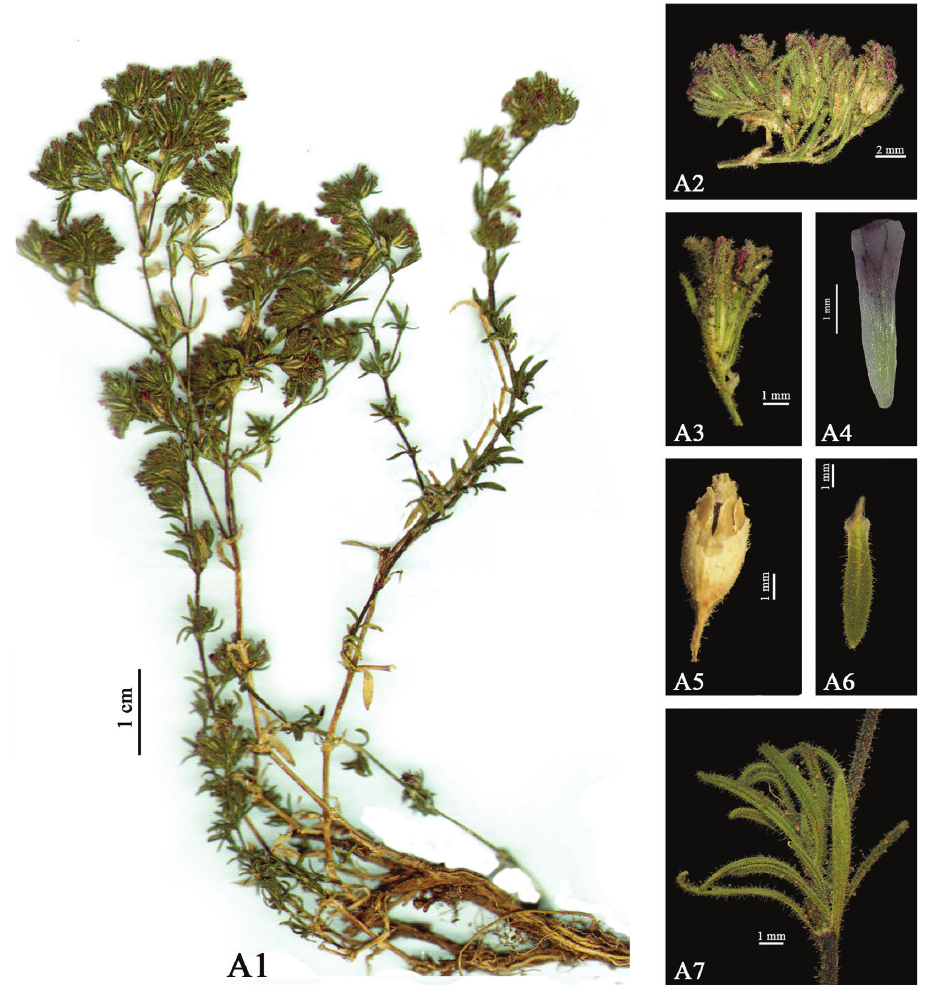
Figure 1. A: Bolanthus turcicus (EH 7110). 1 Habit 2 Inflorescence 3 Flower 4 Petal 5 Capsule 6 Leaf 7 Leaf axillary